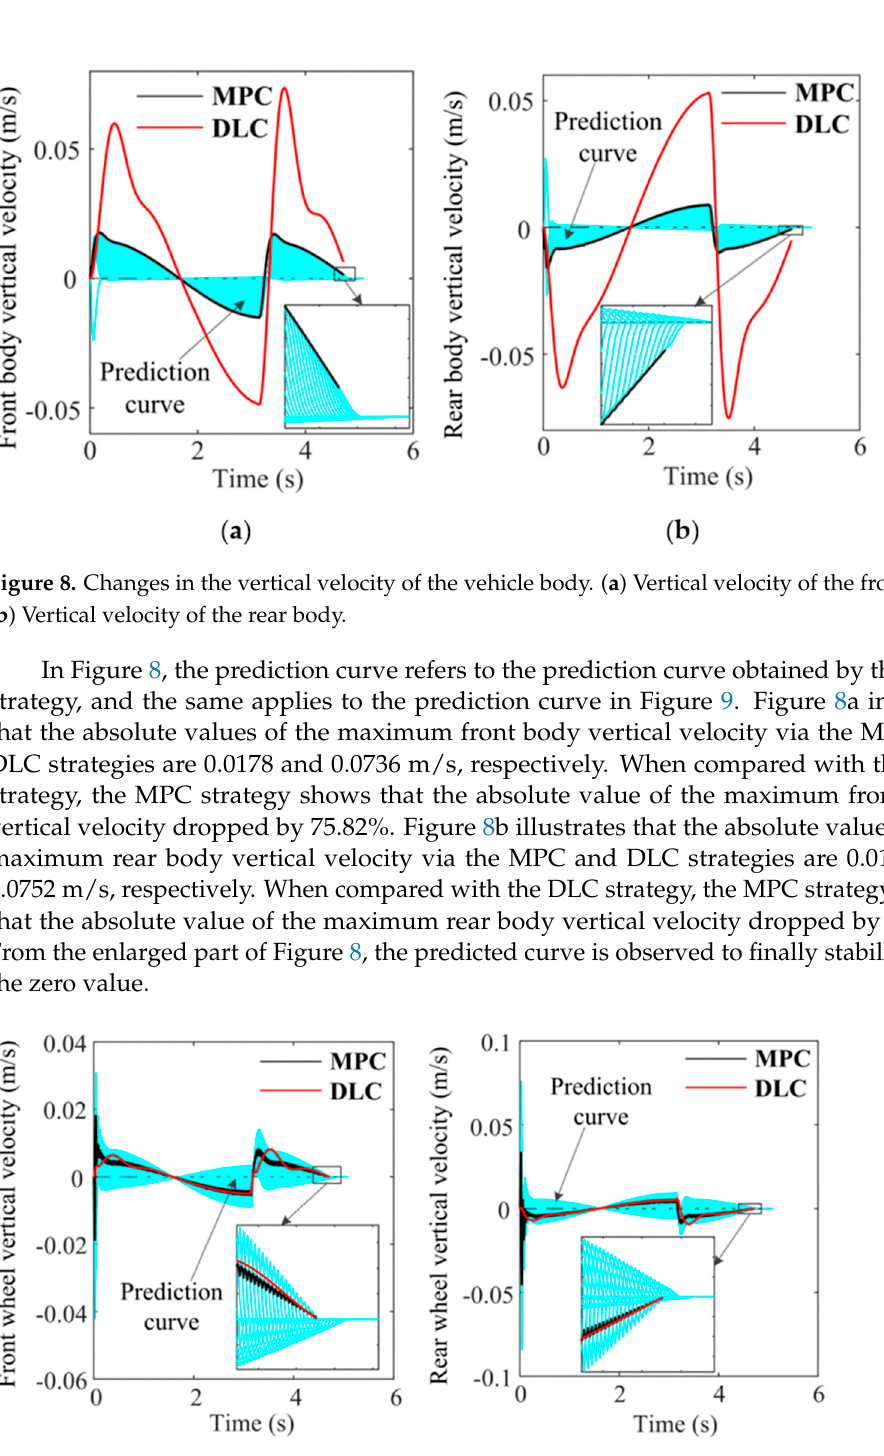
Figure 9. Changes in the vertical velocity of the wheels. ( a ) Vertical velocity of the front wheel; ( b ) Vertical velocity of the rear wheel.